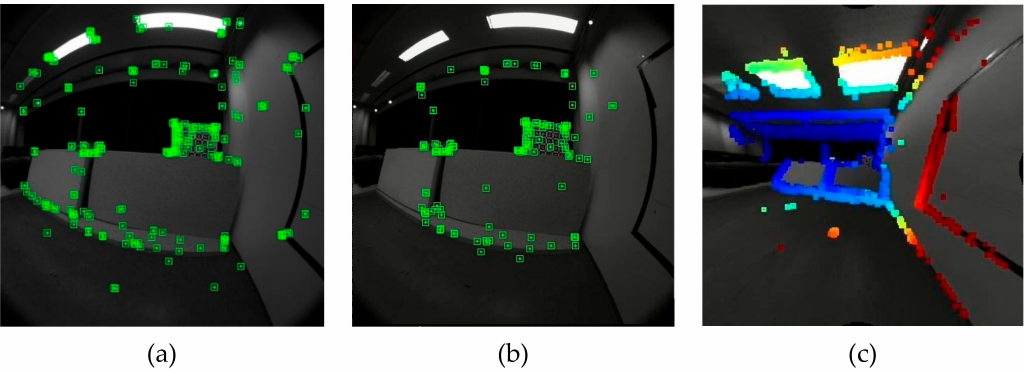
Figure 1. The selected points in a same scene: ( a ) The improved ORB-simultaneous localization and mapping (SLAM) with omnidirectional camera; ( b ) the normal ORB-SLAM; ( c ) Direct Sparse